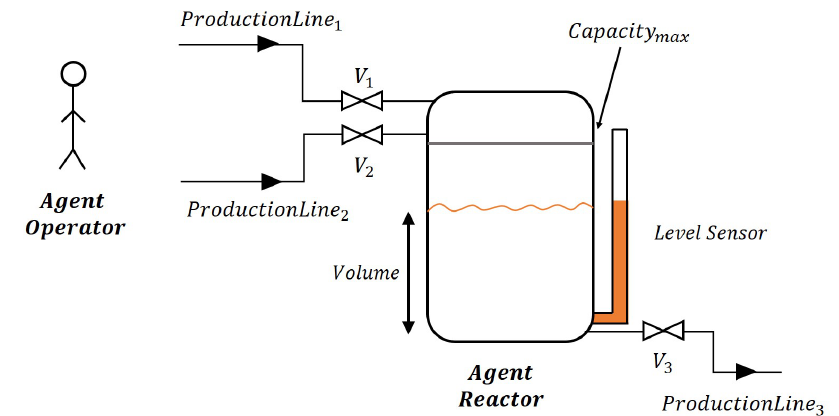
Figure 9. Chemical